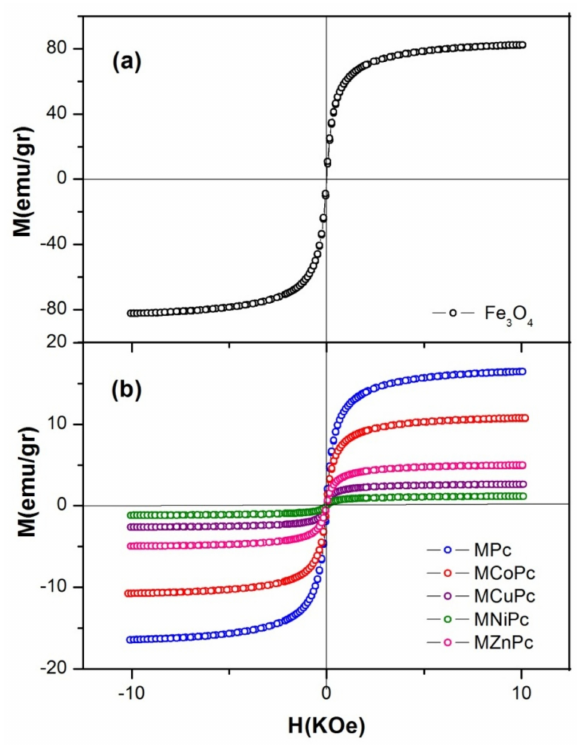
Figure 5. Magnetization curves of pure ( a ) Fe 3 O 4 and ( b ) Fe 3 O 4 @OA /